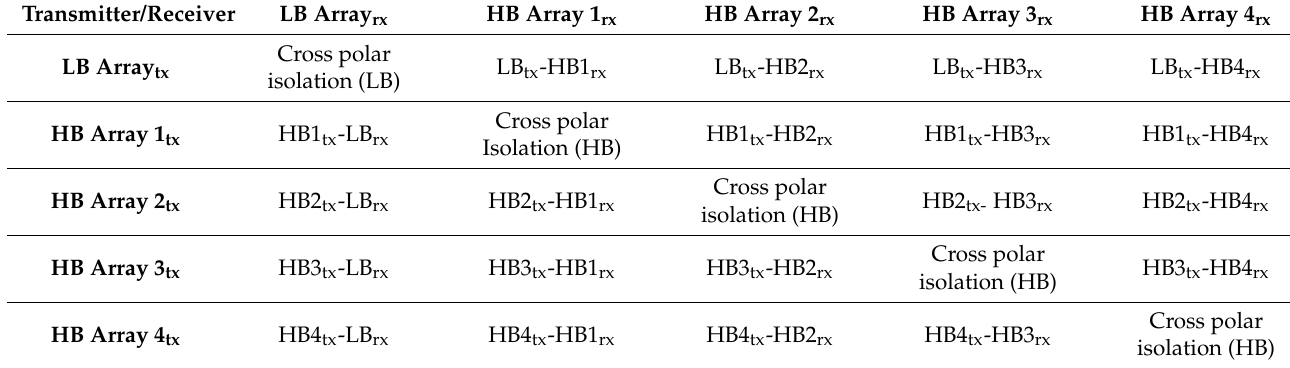
Table 3. Port-to-port isolation combinations for the multiband antenna depicted in Figure